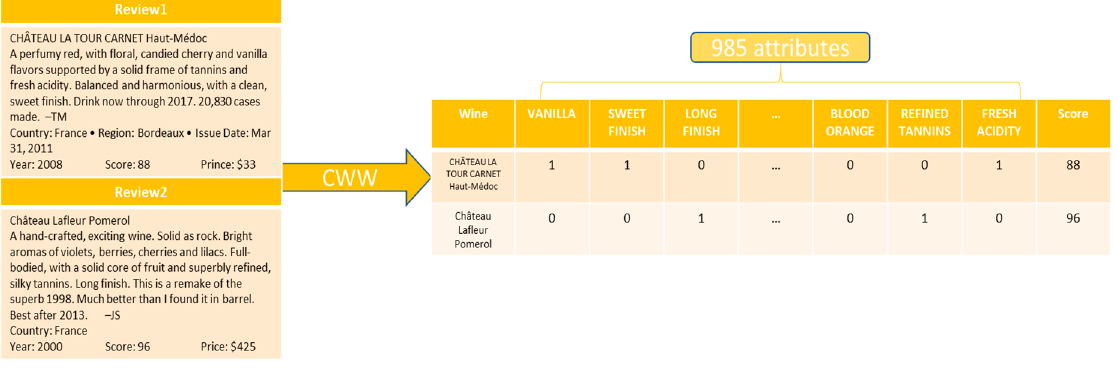
Figure 1. The flowchart of coveting reviews into machine understandable via the computation wine wheel. wine